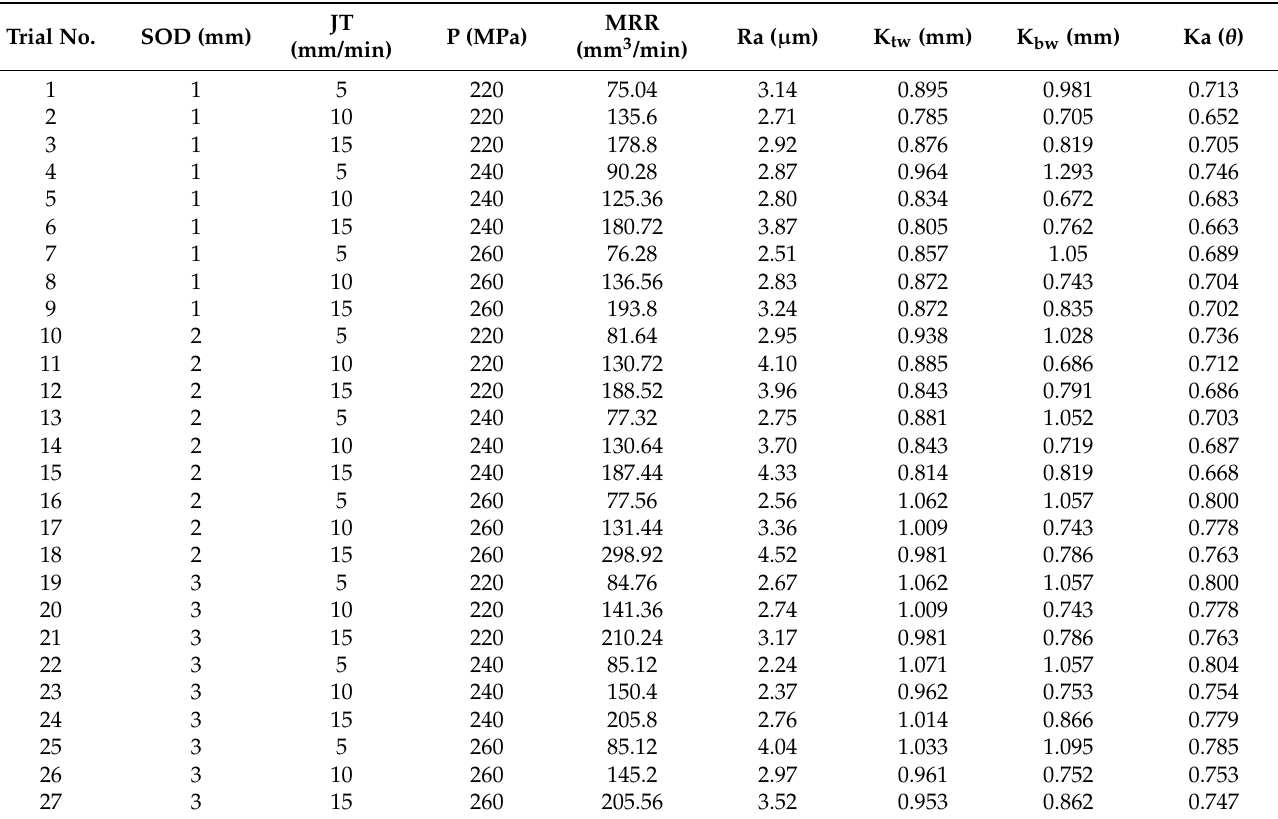
Table 2. The full factorial design and experimental